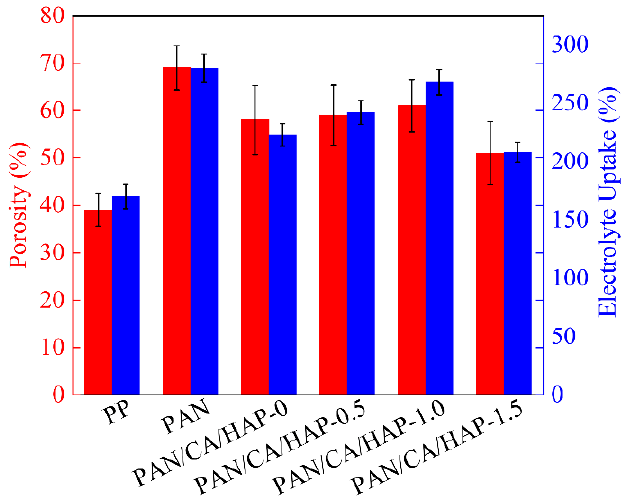
Figure 3. The porosity and electrolyte uptake of different separators.